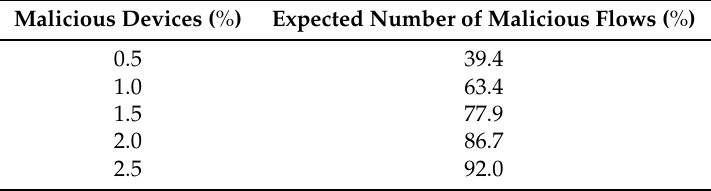
Table 2. Expected number of malicious flows vs. malicious devices.